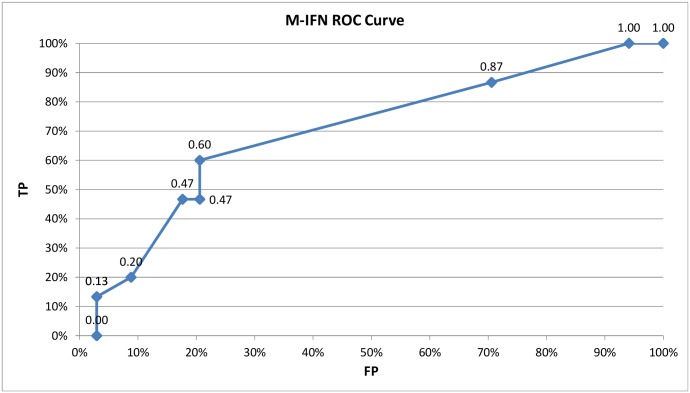
The M-IFN ROC Curve